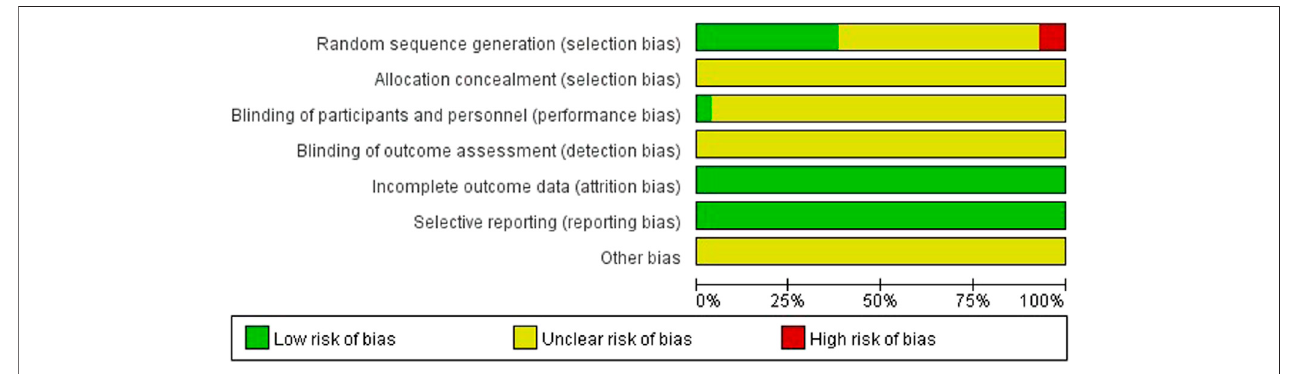
FIGURE 2 | Assessment of risk of